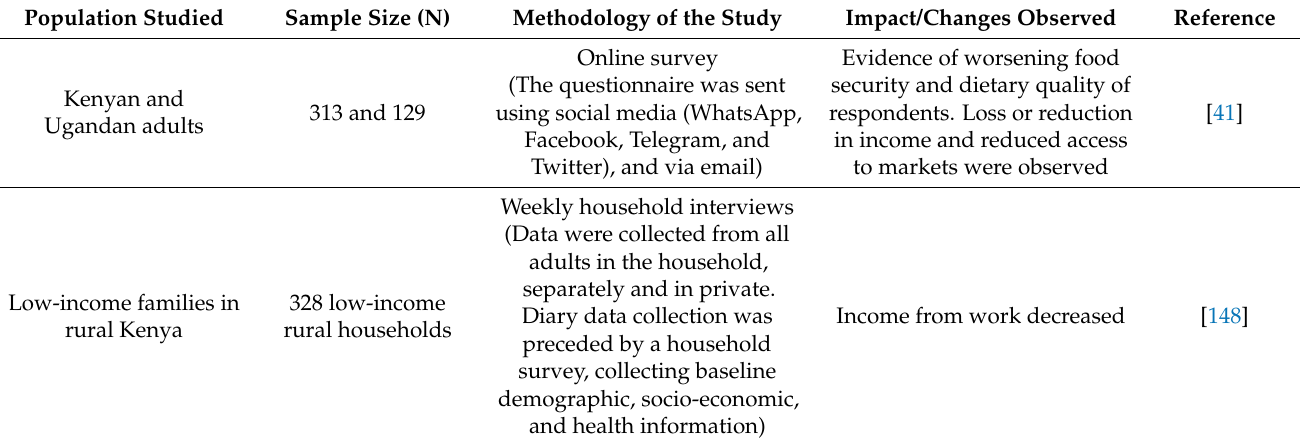
Table 7. Brief summary of studies related to the consequences of the lockdown in African